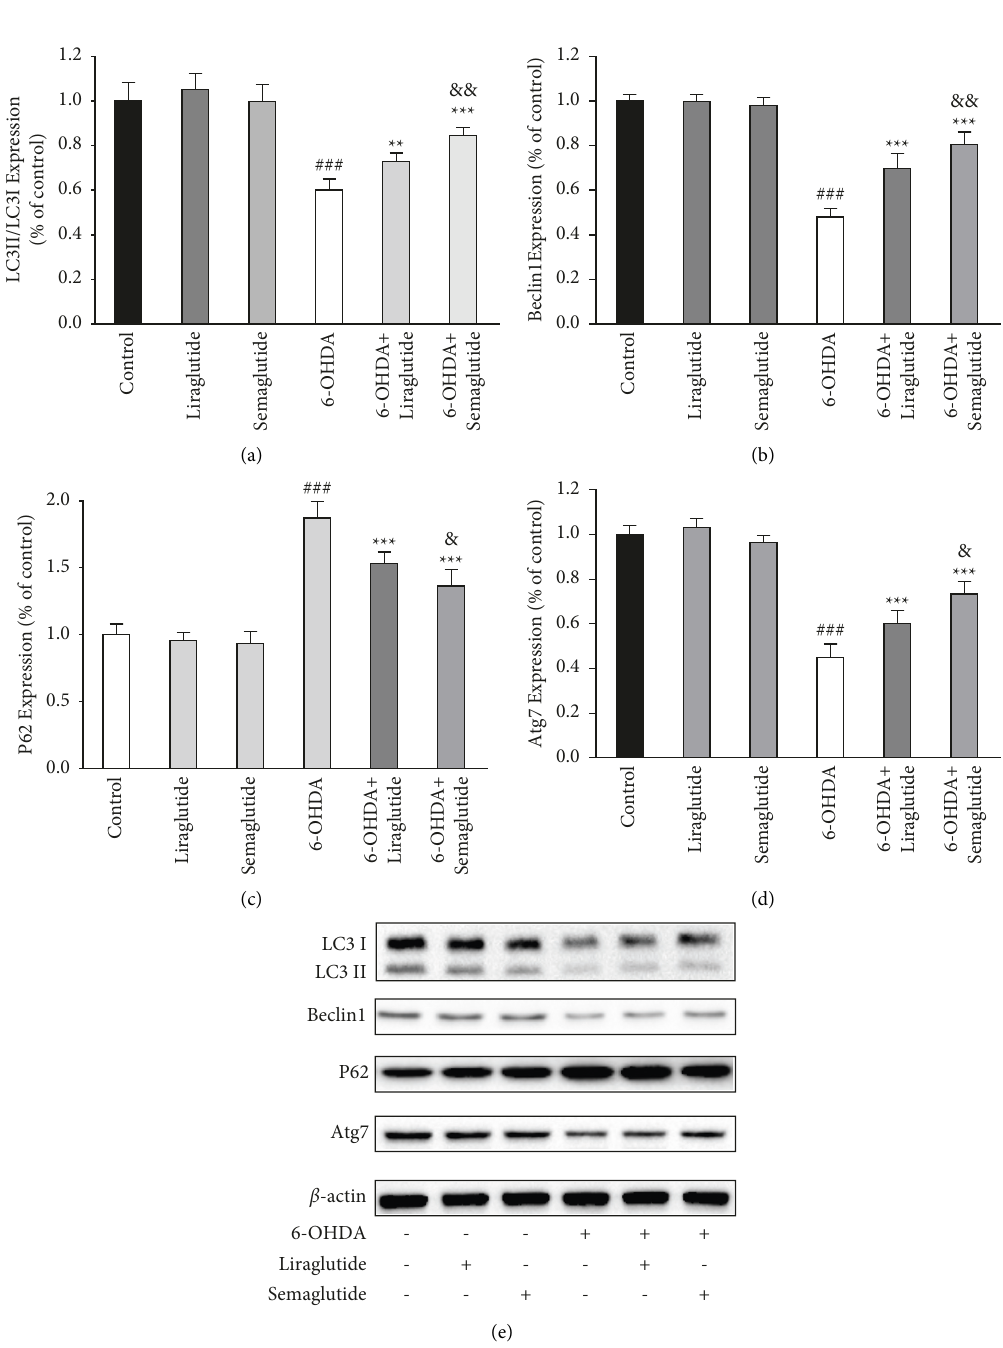
Figure 2: The effect of semaglutide and liraglutide on autophagy-related protein expression in SH-SY5Y cells with 6-OHDA treatment. (a) LC3-II/LC3-I ratio was downregulated in the 6-OHDA group (### P 0 . 001 vs. the control group). Semaglutide and liraglutide normalized P P LC3-II/LC3-I ratio ( 0 . 01, 0 . 001 vs. 6-OHDA group) and semaglutide was significantly more effective ( && P 0 . 01 vs. 6- OHDA+liraglutide group). (b) Beclin-1 expression was downregulated in the 6-OHDA group (### P 0 . 001 vs. the control group). < ∗∗ ∗∗∗ P Semaglutide and liraglutide normalized beclin-1 expression ( 0 . 001 vs. 6-OHDA group) and semaglutide was significantly more < < < effective ( && P 0 . 01 vs. 6-OHDA+liraglutide group). (c) P62 expression was upregulated in the 6-OHDA group (### P 0 . 001 vs. the < ∗∗∗ P 0 . 001 vs. 6-OHDA group) and semaglutide was significantly control group). Semaglutide and liraglutide normalized P62 expression ( < more effective ( & P 0 . 05 vs. 6-OHDA+ liraglutide group). (d) Atg7 expression was downregulated in the 6-OHDA group (### P 0 . 001 vs. < < ∗∗∗ P 0 . 001 vs. 6-OHDA group) and semaglutide was the control group). Semaglutide and liraglutide normalized Atg7 expression ( < significantly more effective ( & P 0 . 05 vs. 6-OHDA+liraglutide group). (e) Western blots of LC3-II, LC3-I, beclin-1, p62, and Atg7 < < ∗∗∗ expression. All data were expressed as mean standard deviation ( n < (cid:30) < ±